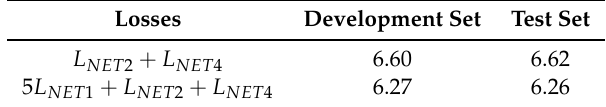
Table 1. The EERs (%) on the development and test sets with and without L NET 1 .